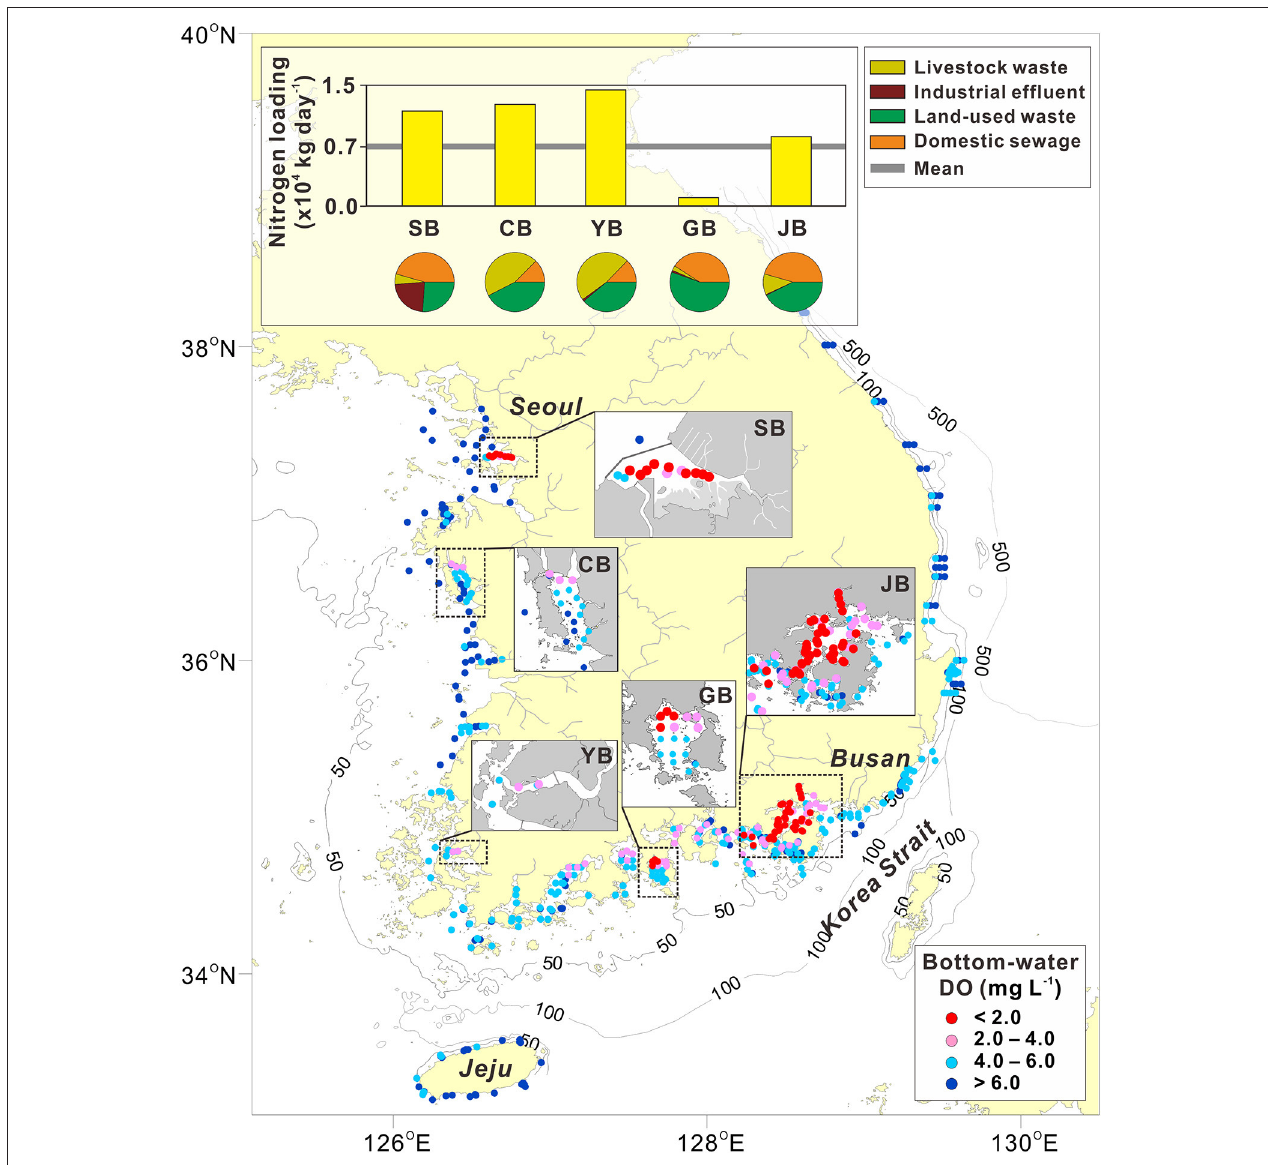
FIGURE 1 | A map showing the minimum values of bottom-water dissolved oxygen (DO) recorded in Koran coastal waters. Five representative hypoxic regions—Shihwa Bay (SB), Cheonsu Bay (CB), Yeongsan Bay (YB), Gamak Bay (GB), and Jinhae Bay (JB)—are highlighted on the map. Most DO data used in the construction of this figure was obtained from the Fishing Ground Environment Monitoring program conducted during 2009–2016 by the National Institute of Fisheries Science (http://www.nifs.go.kr/femo/), but the SB DO data were obtained from the Ministry of Oceans and Fisheries (MOF) reports (MOF, 2005, 2006, 2007, 2008, 2009, 2010, 2011). The inset indicates the total nitrogen (N) loading (yellow bars) and contributions (pie charts) of the four major N sources (livestock waste, yellow; industrial effluent, brown; land-used waste, green; domestic sewage, orange) discharged to the watershed in each bay (data source, MOF, 2013). The solid gray line indicates the mean value of the total N loading in the Korean coastal region. The dots represent the bottom-water DO concentrations (red dots, < 2mg L − 1 ; pink dots, 2–4mg L − 1 ; light-blue dots, 4–6mg L − 1 ; blue dots, > 6mg L − 1